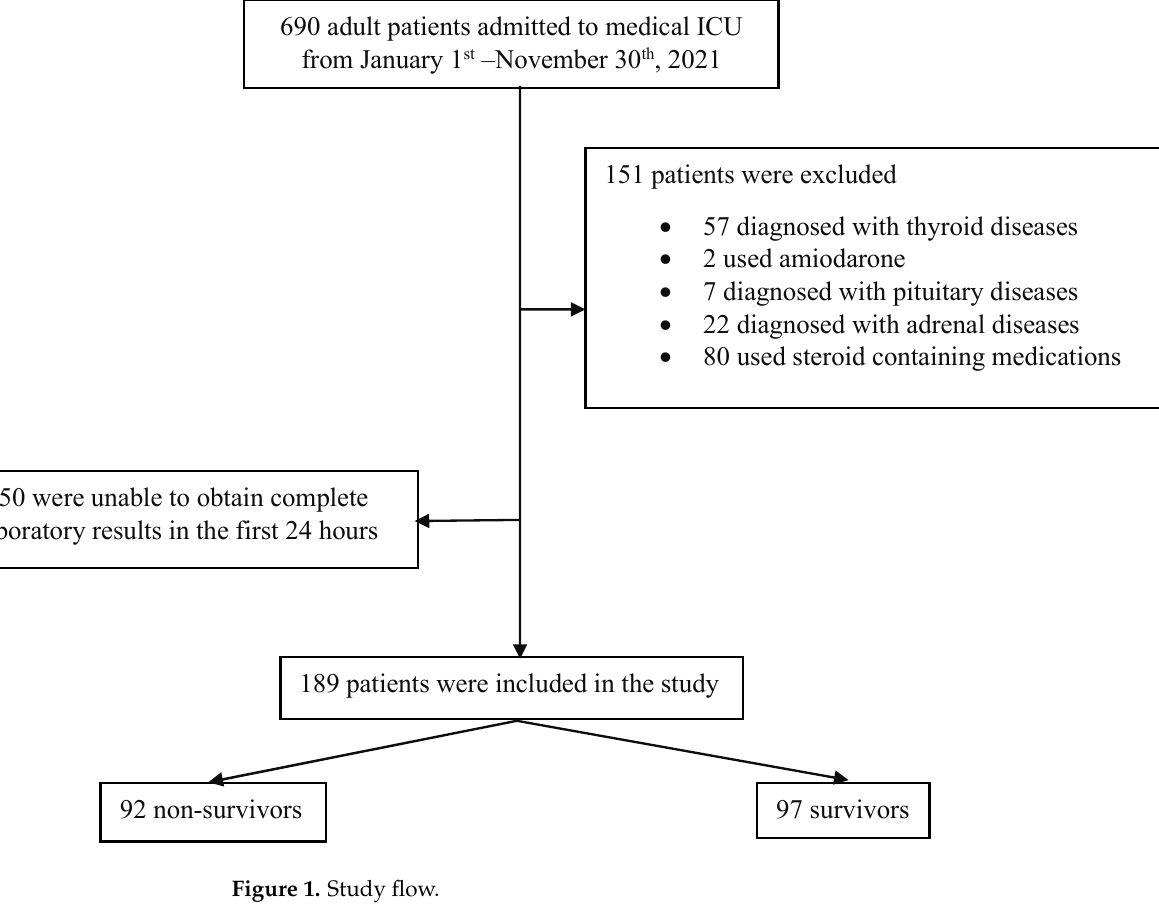
Figure 1. Study flow.